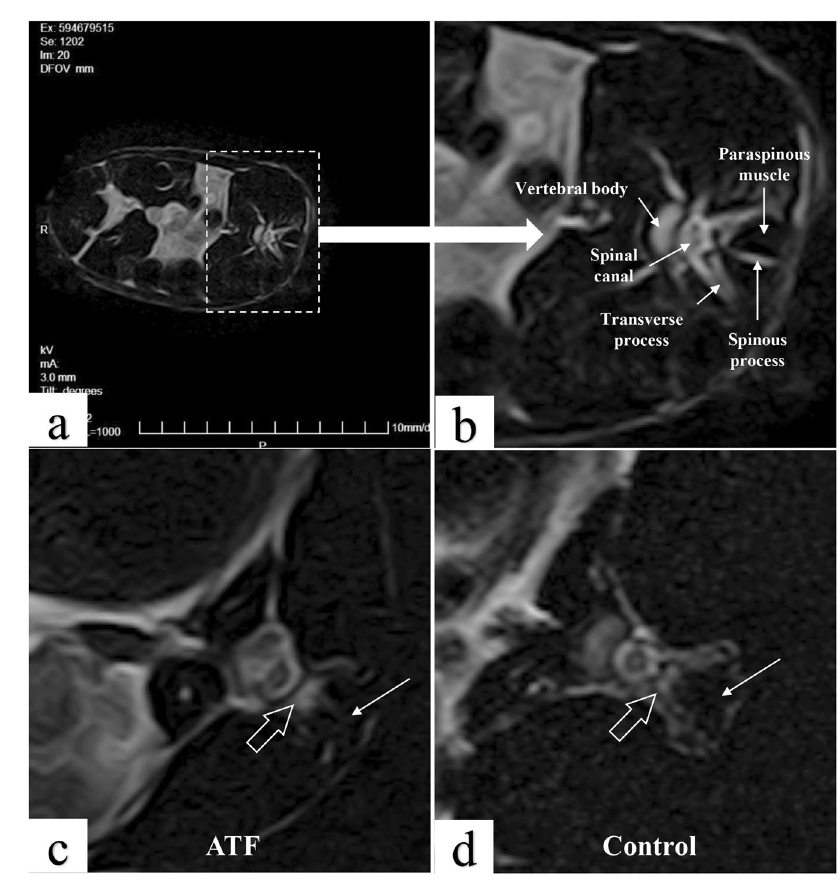
Fig. 2 MRI scan results of paraspinal muscle for volume evaluation in rabbits. a Magni fi ed fi gure of MRI on lumbosacral spine of normal New Zealand white rabbit; b MRI structure of normal L5; c MRI results showed regular shape and basically uniform signal of paraspinous muscle in ATF group; d MRI results showed the irregular shape and uneven signal of the boundary of paraspinous muscle in control group. The white arrow indicates the paraspinous muscle, and the white transparent arrow indicates the space between the paraspinous muscle and the